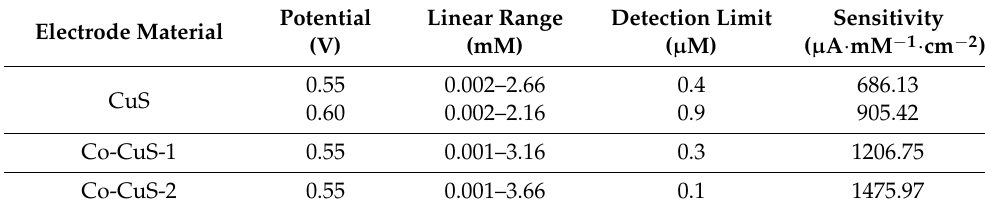
Table 2. Comparison of the Co-CuS-2 electrode with some reported sensors for glucose